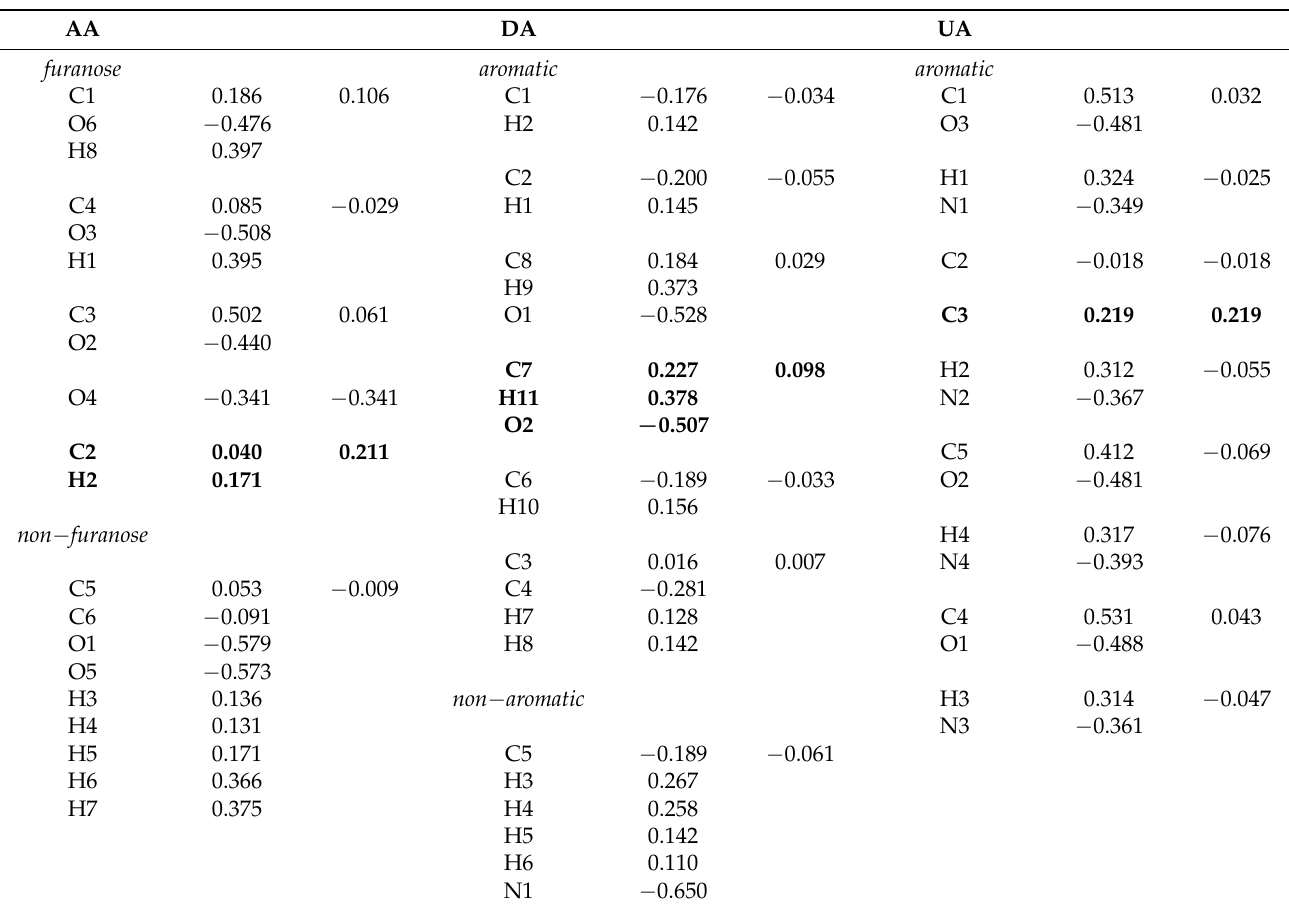
Table 2. Partial charge on each atom of AA, DA, and UA calculated from the Löwdin population of valence electrons. Total charge on each of the atom groups defined in Figure 2 is also shown. The bold fonts highlight the atom group with the highest positive partial charge for each